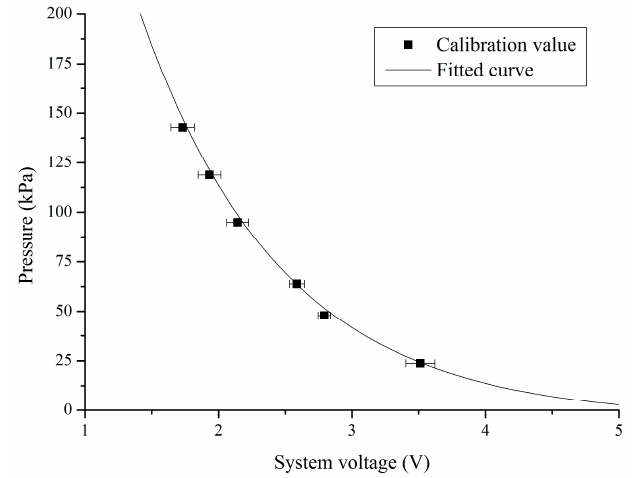
Figure 10. Curve of pressure and system output voltage.